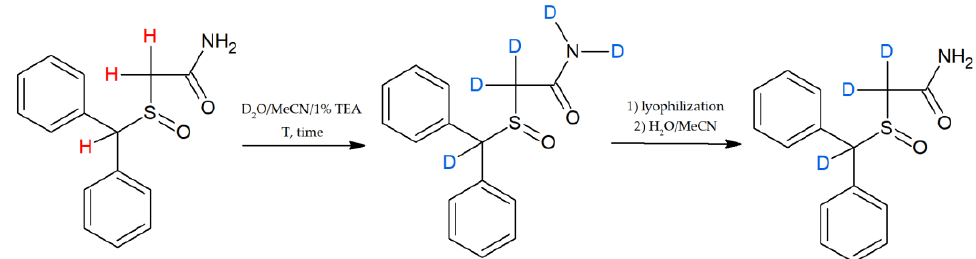
Figure 3. Schematic reaction of hydrogen–deuterium exchange for armodafinil [75]. Carbamazepine